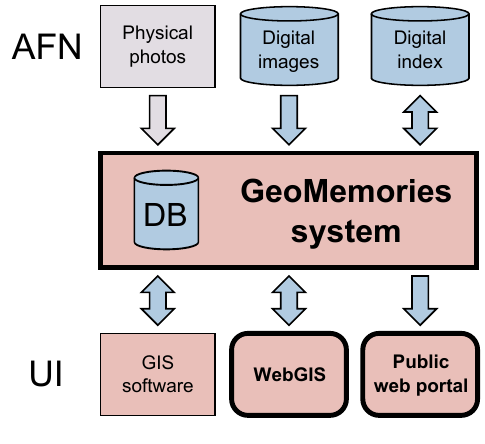
Figure 6. The GeoMemories architecture. Data from AFN archives is processed and stored